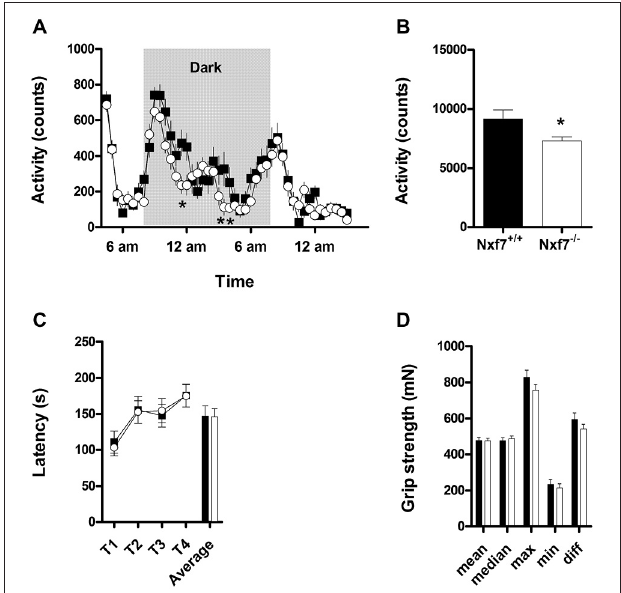
FIGURE 1 | Activity and neuromotor assessment in wildtype (WT) and Nxf7 knockout (KO) mice. Overall 23 h activity was not different between the two genotypes (A) , but during the dark period, Nxf7 KO (open symbols, N = 21) were significantly less active than WT mice (black symbols, N = 20) (B) . Balance on the rotarod (C) and grip strength (D) was not different between the two genotypes. Data are expressed as means ± SEM. * p < 0.05 Nxf7 KO vs. WT (RM-ANOVA, post hoc comparison).